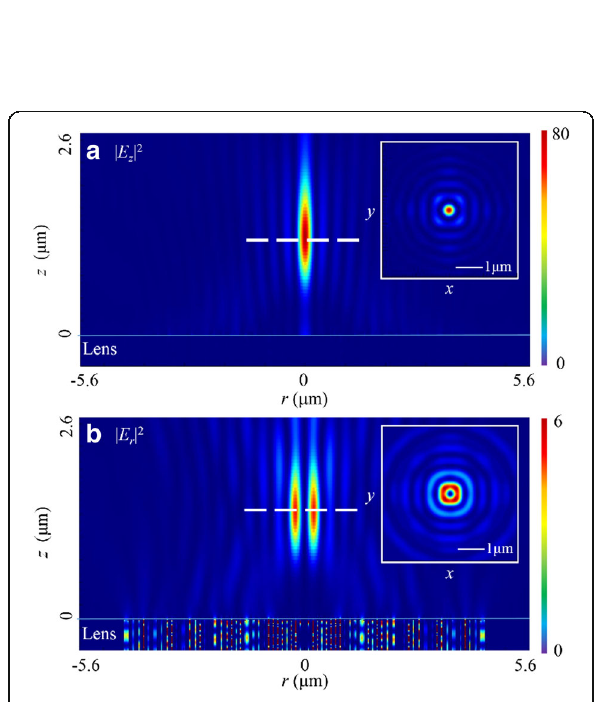
Fig. 9 Intensity distribution patterns of | E z | 2 and | E r | 2 in r-z plane in the case of radially polarized light. a | E z | 2 pattern in the r-z plane. The inset shows a circular-shape focus in the focal plane. b The transverse | E r | 2 pattern in the r-z plane. The inset shows a donut- shape focus in the focal